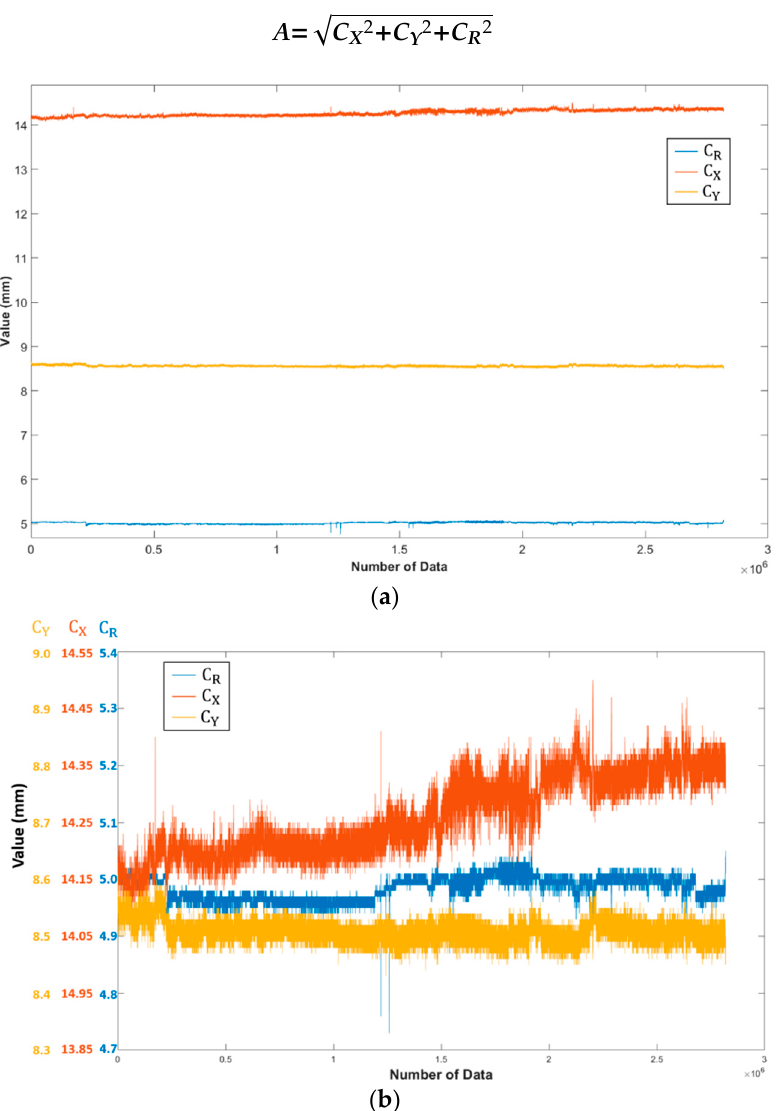
Figure 5. ( a ). Data recorded trends for the circle radii C R , eccentric positions measured along the x-axis ( C X ) and y-axis ( C Y ) by every 16 points moving average. ( b ). Data recorded for the diameter of the circular image ( C R ) with eccentric position along the x-axis as shown on CCD ( C X ) and eccentric position along the y-axis as shown on CCD ( C Y